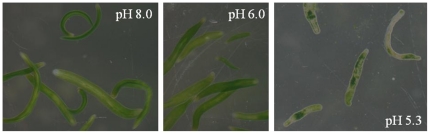

Symsagittifera roscoffensis after a 24 h exposure to seawater with different pH (experiment 5).Animals in the lower pH started to bleach.